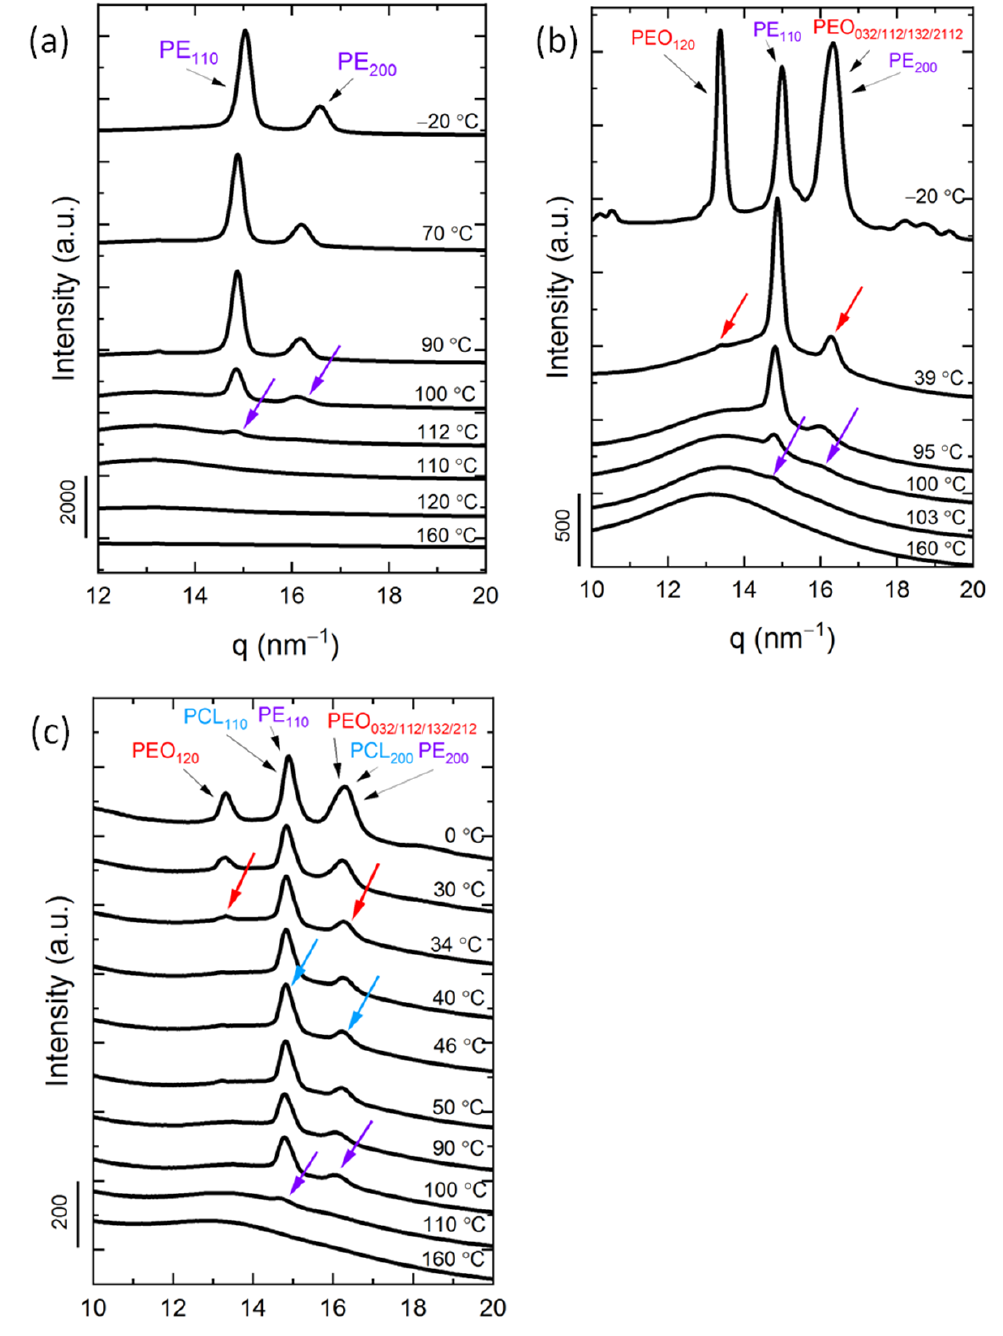
Figure 8. Normalized WAXS intensities as a function of temperature calculated from WAXS data represented in Figure 7 for ( a ) PE 9.5 (PE 110 (15.4 nm − 1 )), ( b ) PE 529.5 -b- PEO 488.8 (PE 110 (15.4 nm − 1 ) and PEO 120 (13.8 nm − 1 )), and ( c ) PE 37 9.5 -b- PEO 348.8 -b- PCL 297.6 (PE 200 (16.9 nm − 1 ), (PCL 1200 (16.7nm − 1 ) and